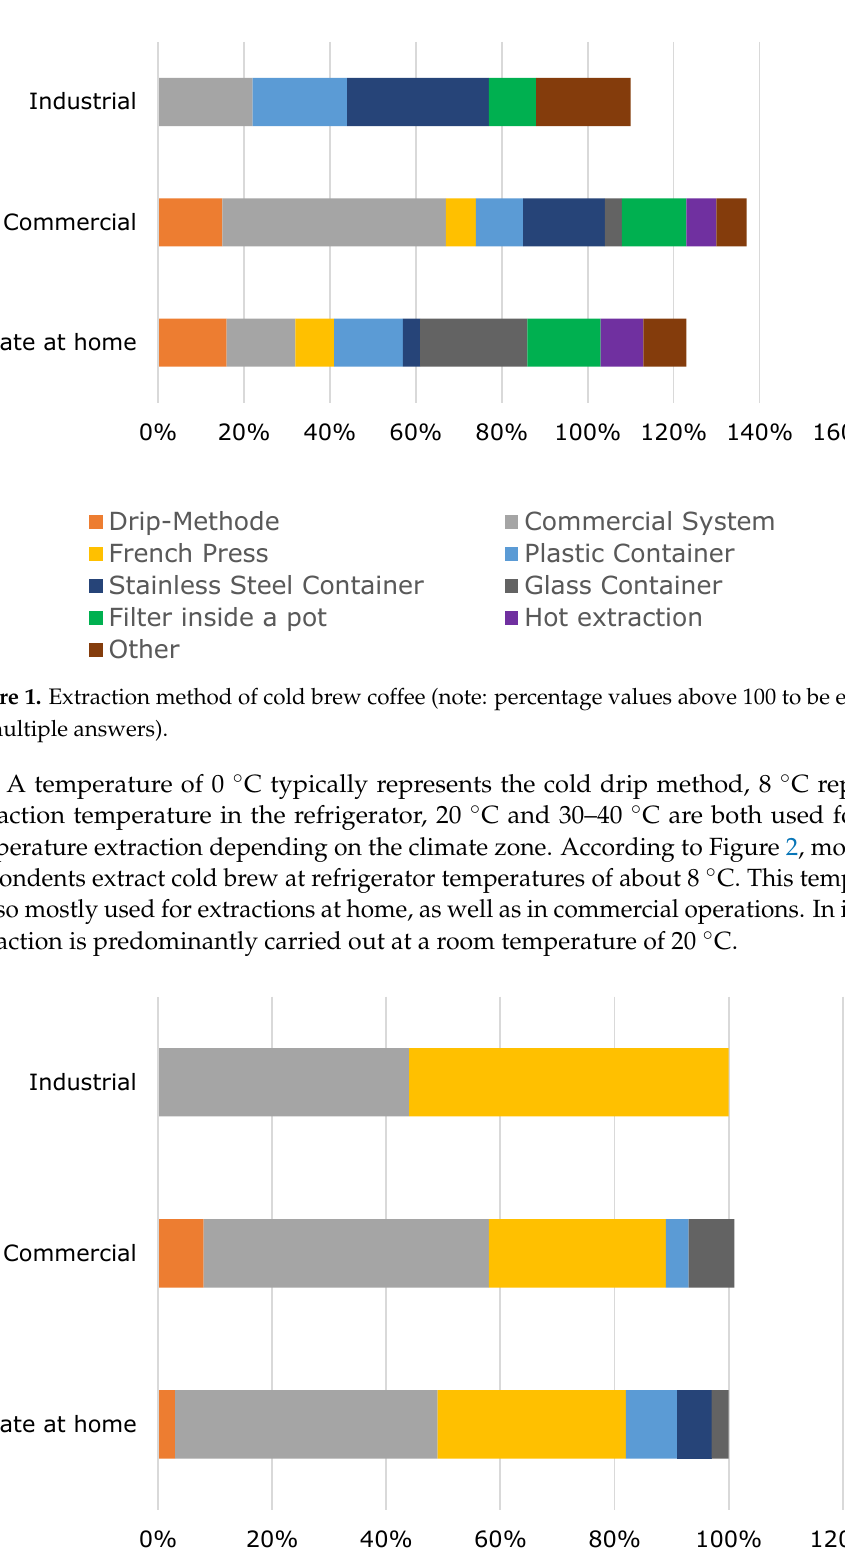
Figure 3. Extraction time of cold brew coffee. As can be seen in Figure 4, coarsely ground coffee is mainly used in each group (home, commercial and industrial). Fine ground coffee is used the least.